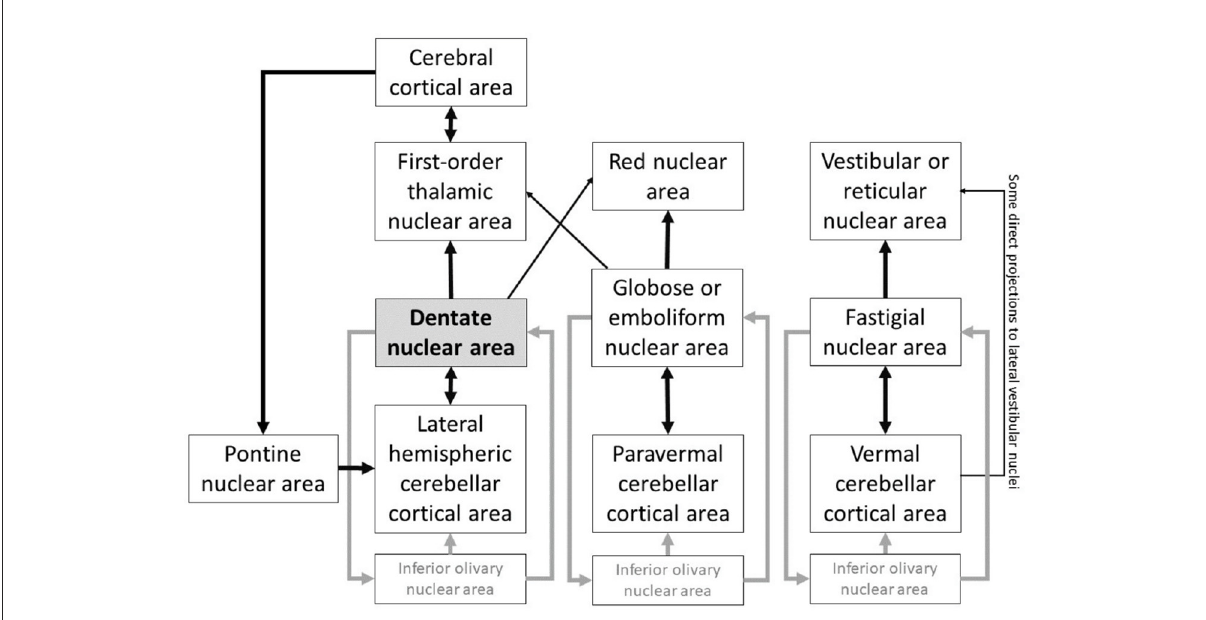
FIGURE1 DN plays a central node in the cerebellar connections to other extracerebellar areas, and is part of a highly complex system of reverberating connections linking the nuclei of the cerebellum to the rest of the brain. Based on (28, 30, 34–40).